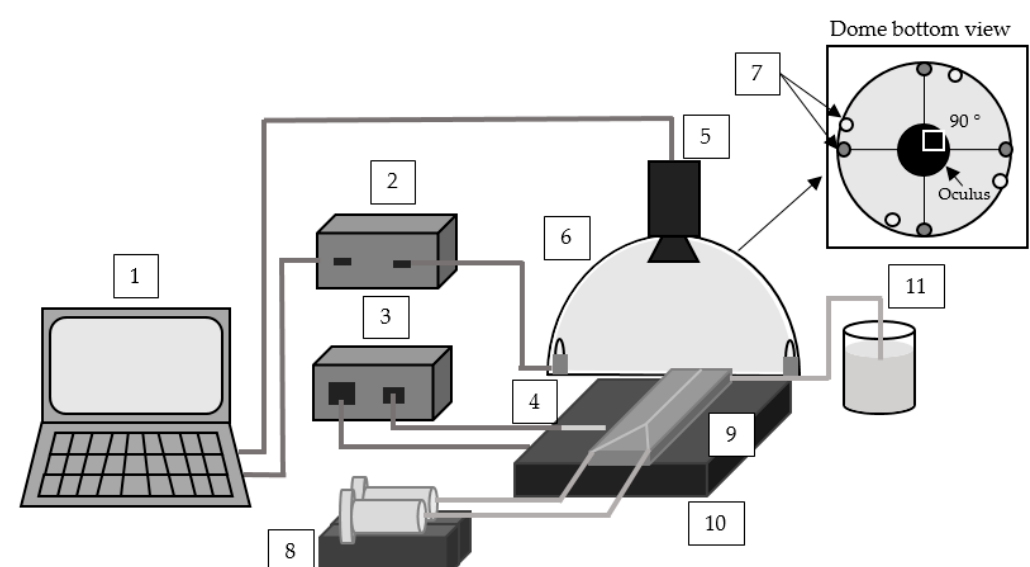
Figure 3. Schematic overview of the experimental setup: computer unit with acquisition software #1, controlling device with microcontroller #2, temperature controller with a temperature sensor type K #3–4, near-infrared camera Goldeye #5, dome lighting #6, near-infrared LEDs, dome (bottom view) #7, syringe pump #8, mini-channel #9, heater #10, and waste container #11.